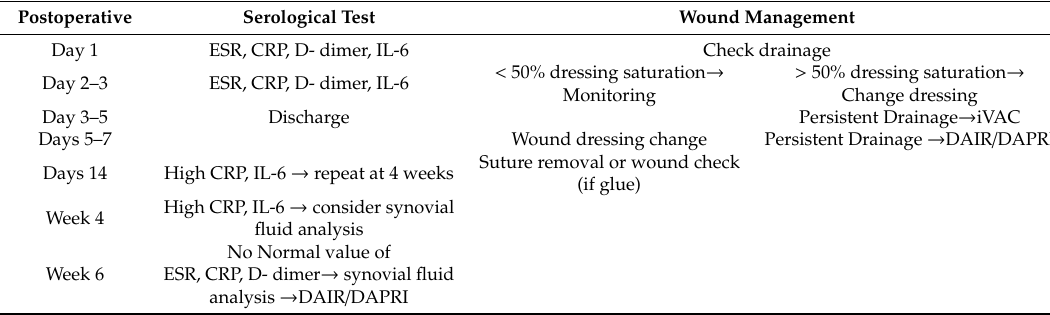
Table 2. Postoperative Monitoring Protocol in High-Risk Patients ( > 130